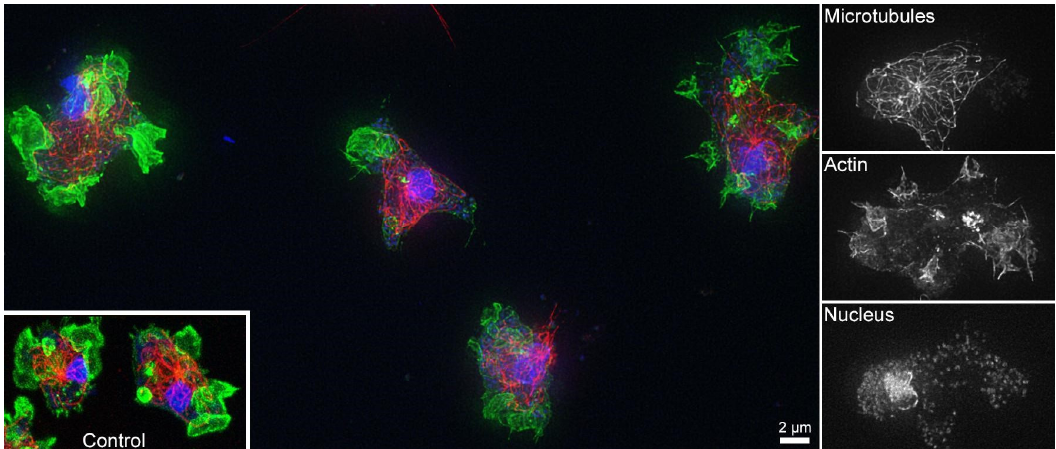
Figure 7. Fluorescence micrographs of Dictyostelium discoideum amoeba on a Min3 surface. Small images to the right show the individual red–green–blue (RGB) channels (rotated by 90°) for the cell at the upper right of the composite image showing microtubules (red), actin (green) and nuclei (blue). A representative image of control cells stained accordingly is shown in the inset. The corresponding data on Min1 and Min2 can be found in the supporting information.